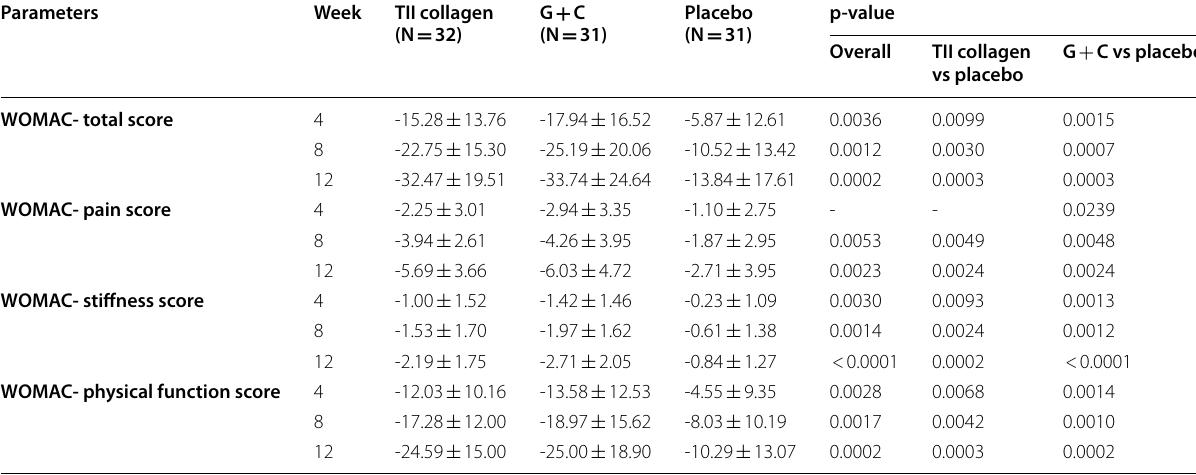
C, and TII collagen group (mITT +